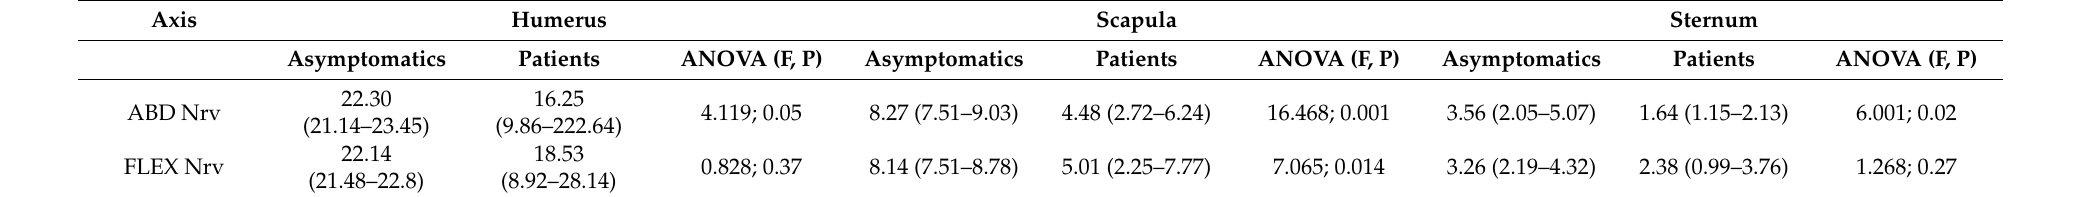
Table 4. Mean (95% CI) acceleration (m/s 2 ) from the resultant vector in abduction and flexion